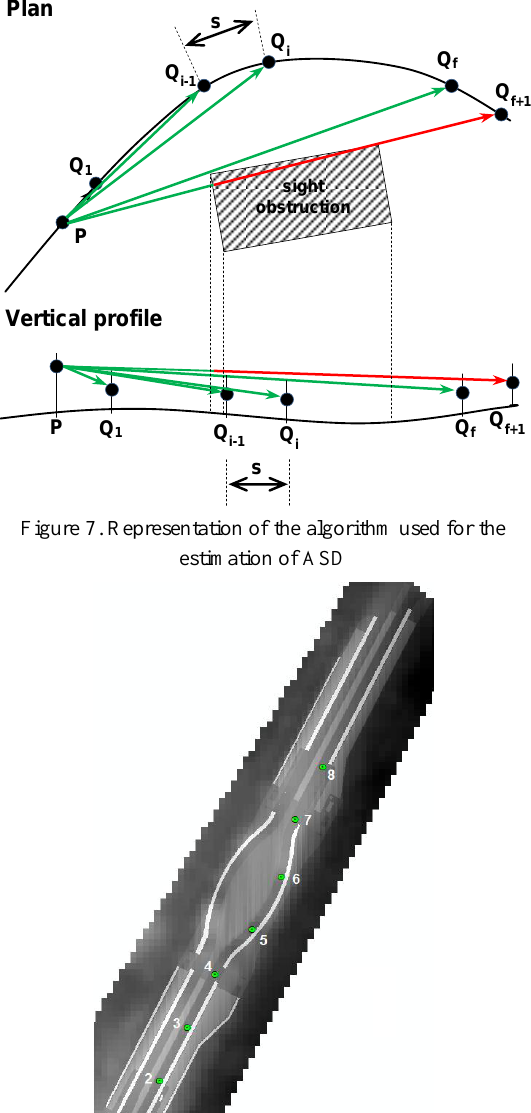
Figure 8. DSM model of the case study with eight points investigated for the ASD